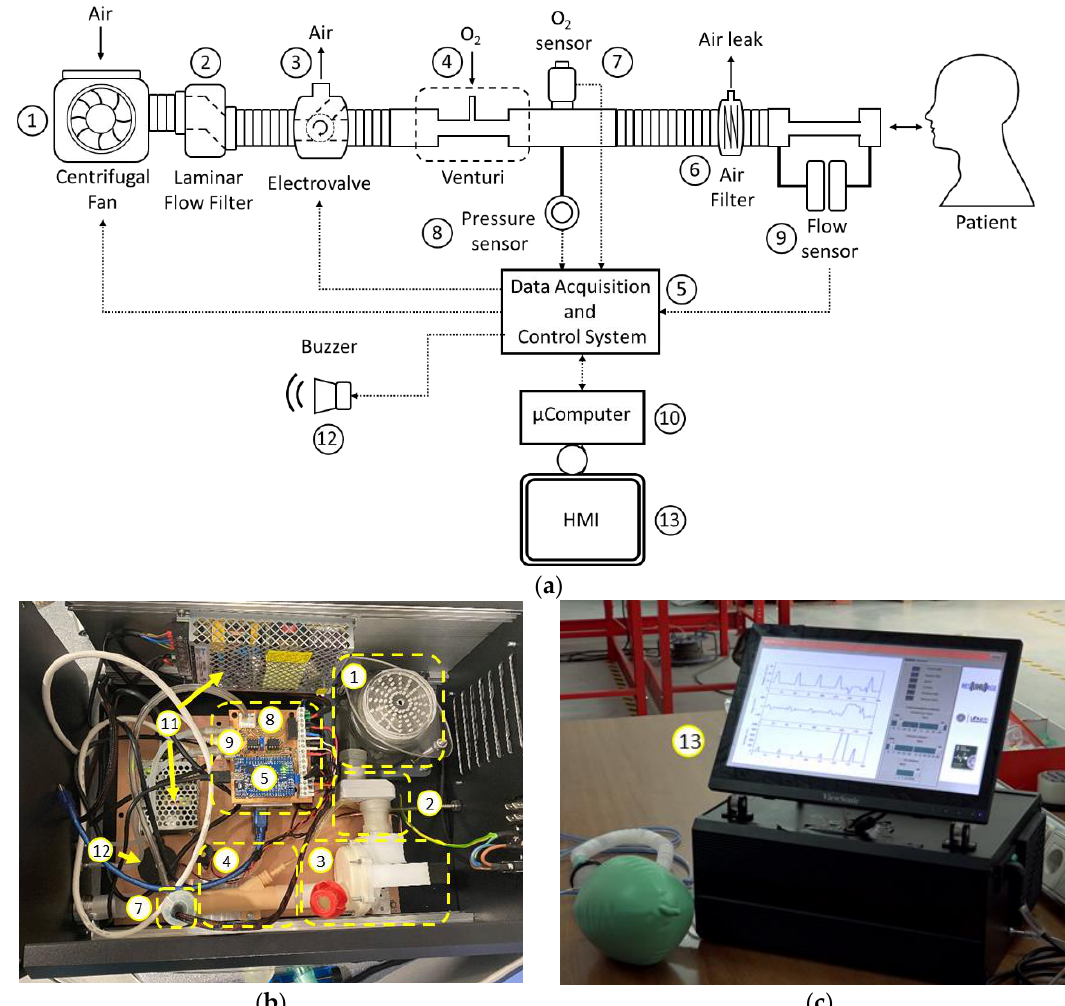
Figure 3. Architecture of ResUHUrge: ( a ) general scheme; ( b ) ResUHUrge interior detail and ( c ) touch screen detail.